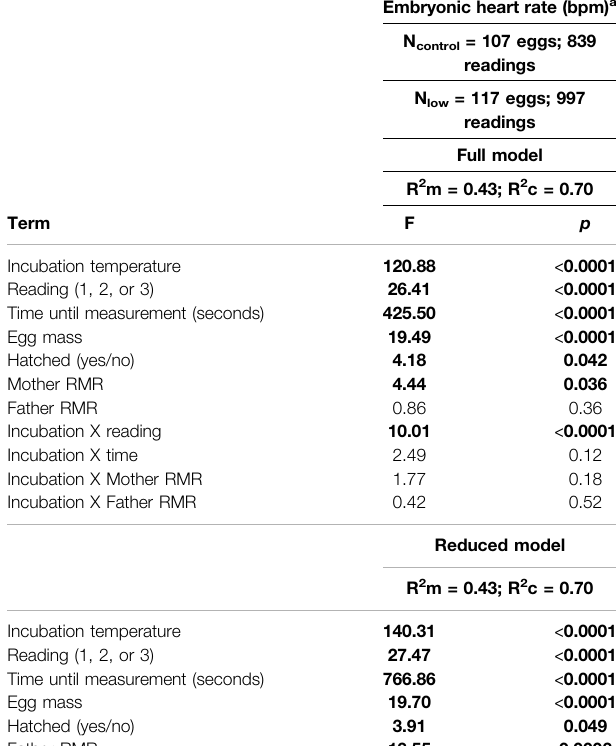
TABLE 2 | Full and reduced models investigating the relationship of embryonic heart rate with incubation temperature and parental metabolism. Embryonic heart rate (bpm)